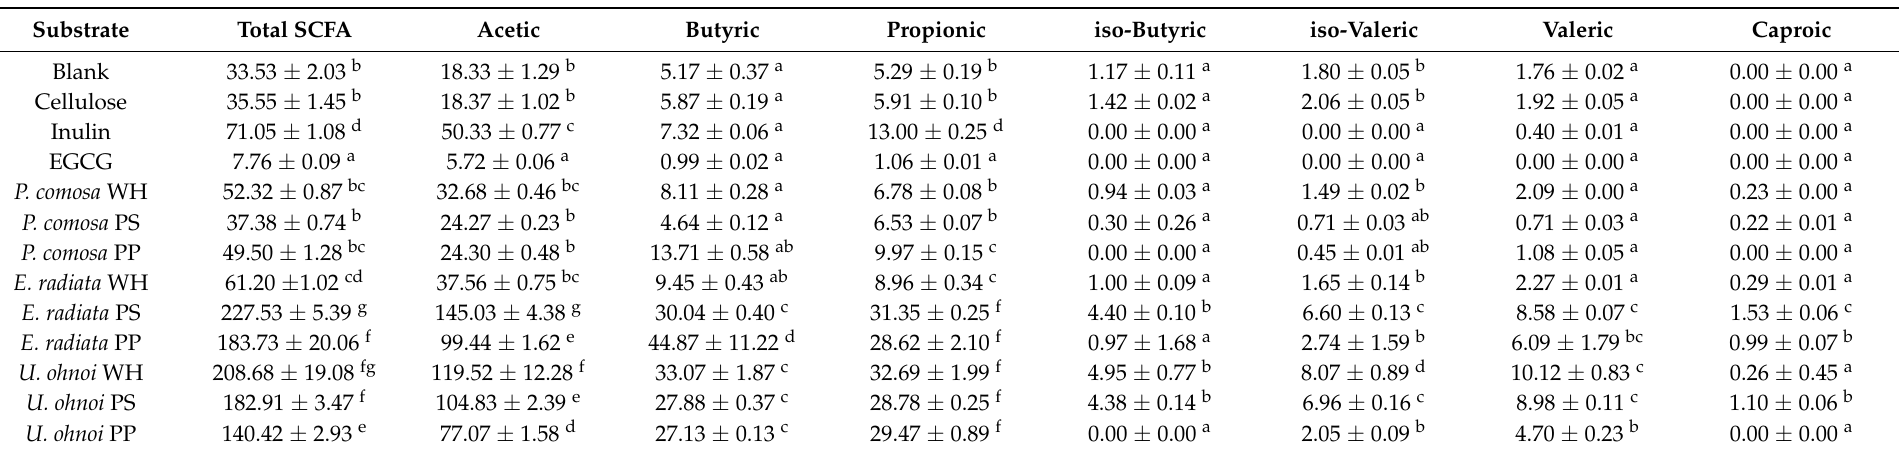
* Letters indicate a significant difference ( p ≤ 0.05) between means within the same